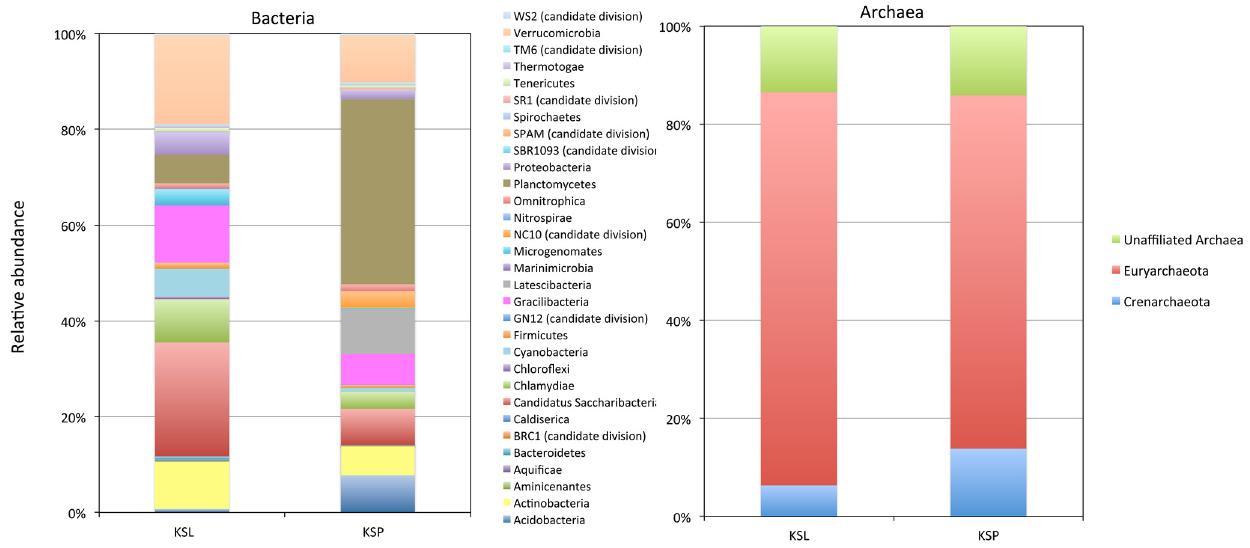
Figure 3. Proportions of the bacterial and archaeal phyla and high taxonomic groups found in two water wells (KSL and KSP) of the Lake Karla Basin,